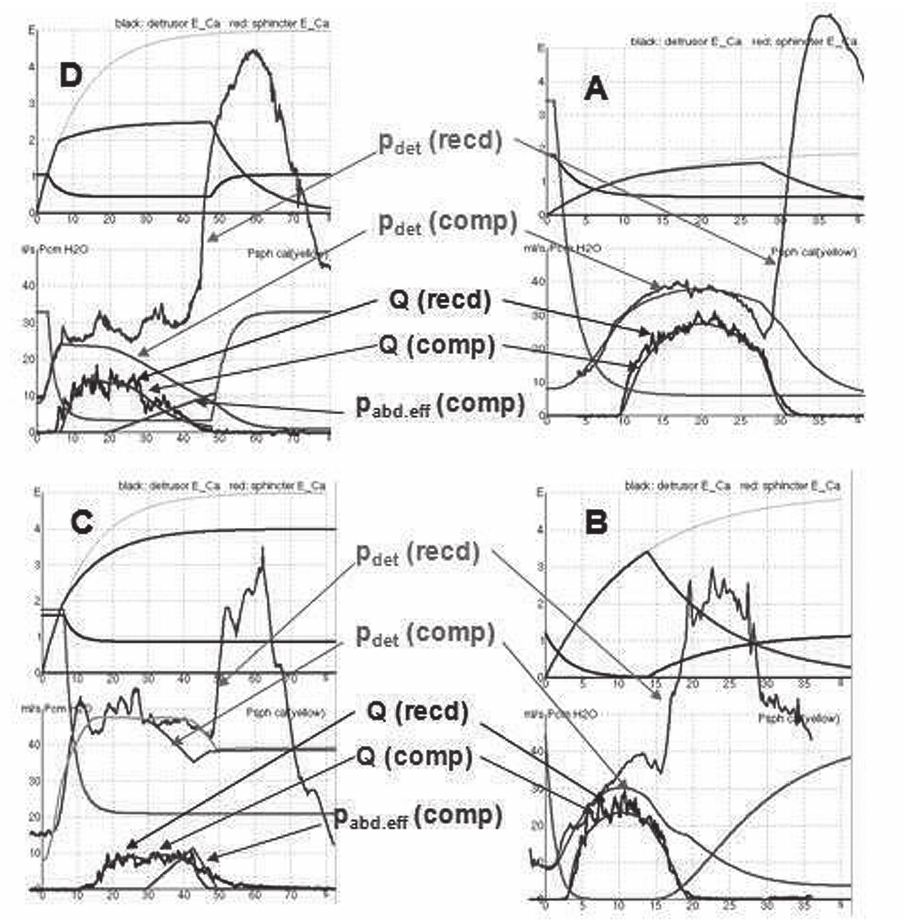
Figure 2 - Four examples of VBN analysis of voidings followed by detrusor after-contraction (DAC) in female patients. The description only concerns the lower register (flow and pressures): Q (recd) (red)= recorded Q; Q (comp) (blue)= computed